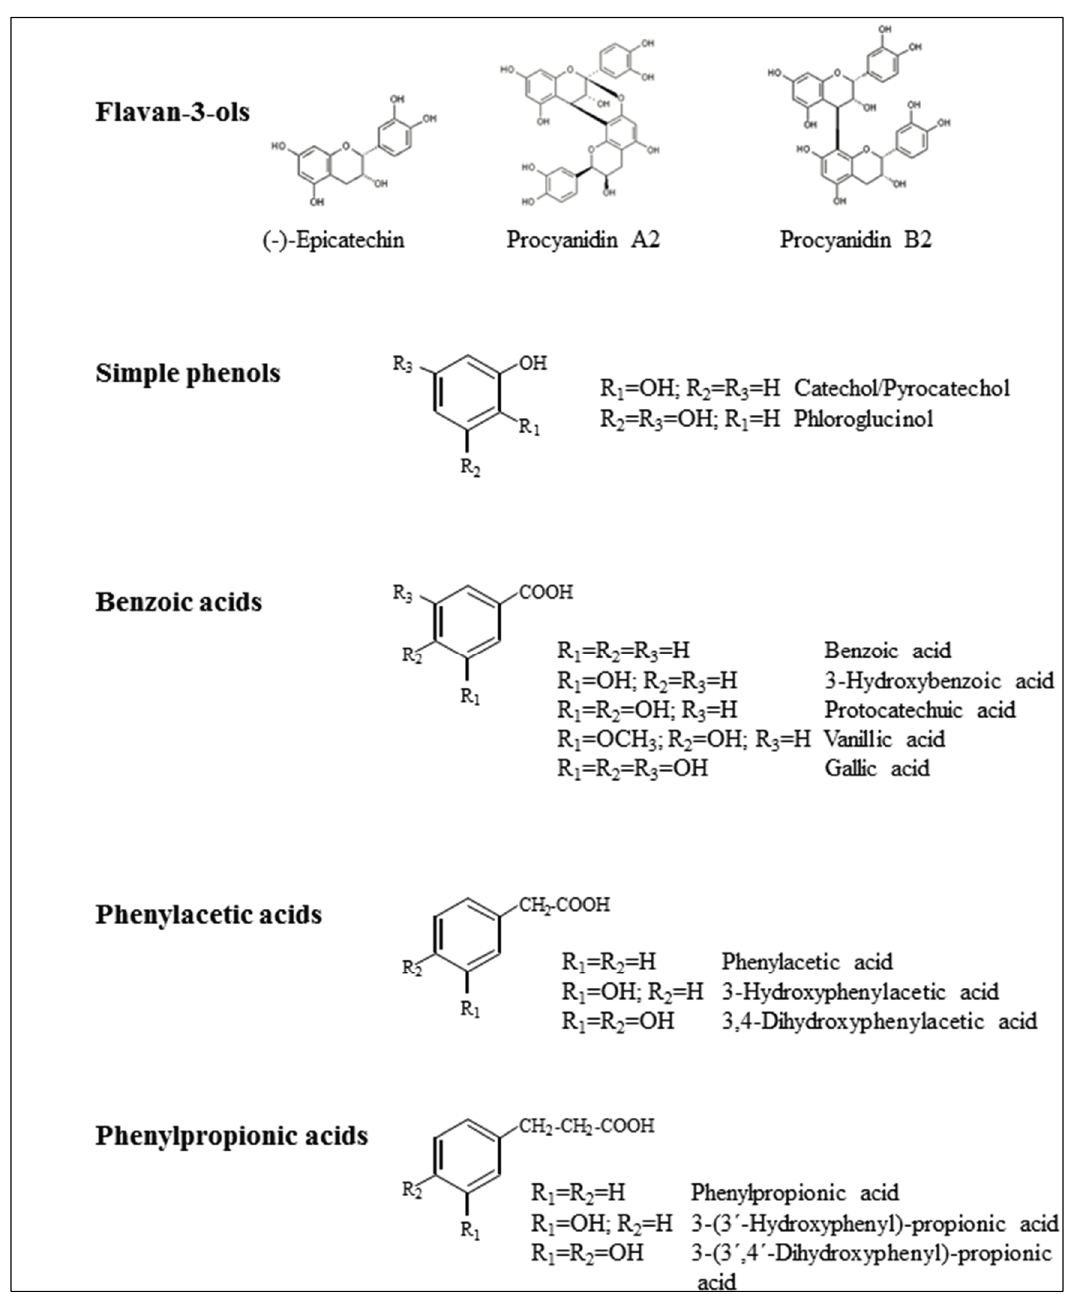
Figure 1. Chemical structures of phenolic compounds tested for their anti-adhesive activity against uropathogenic Escherichia coli